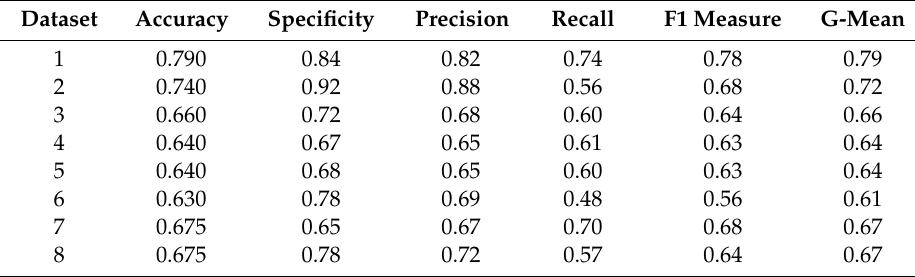
Table 2. Results for Artificial Neural